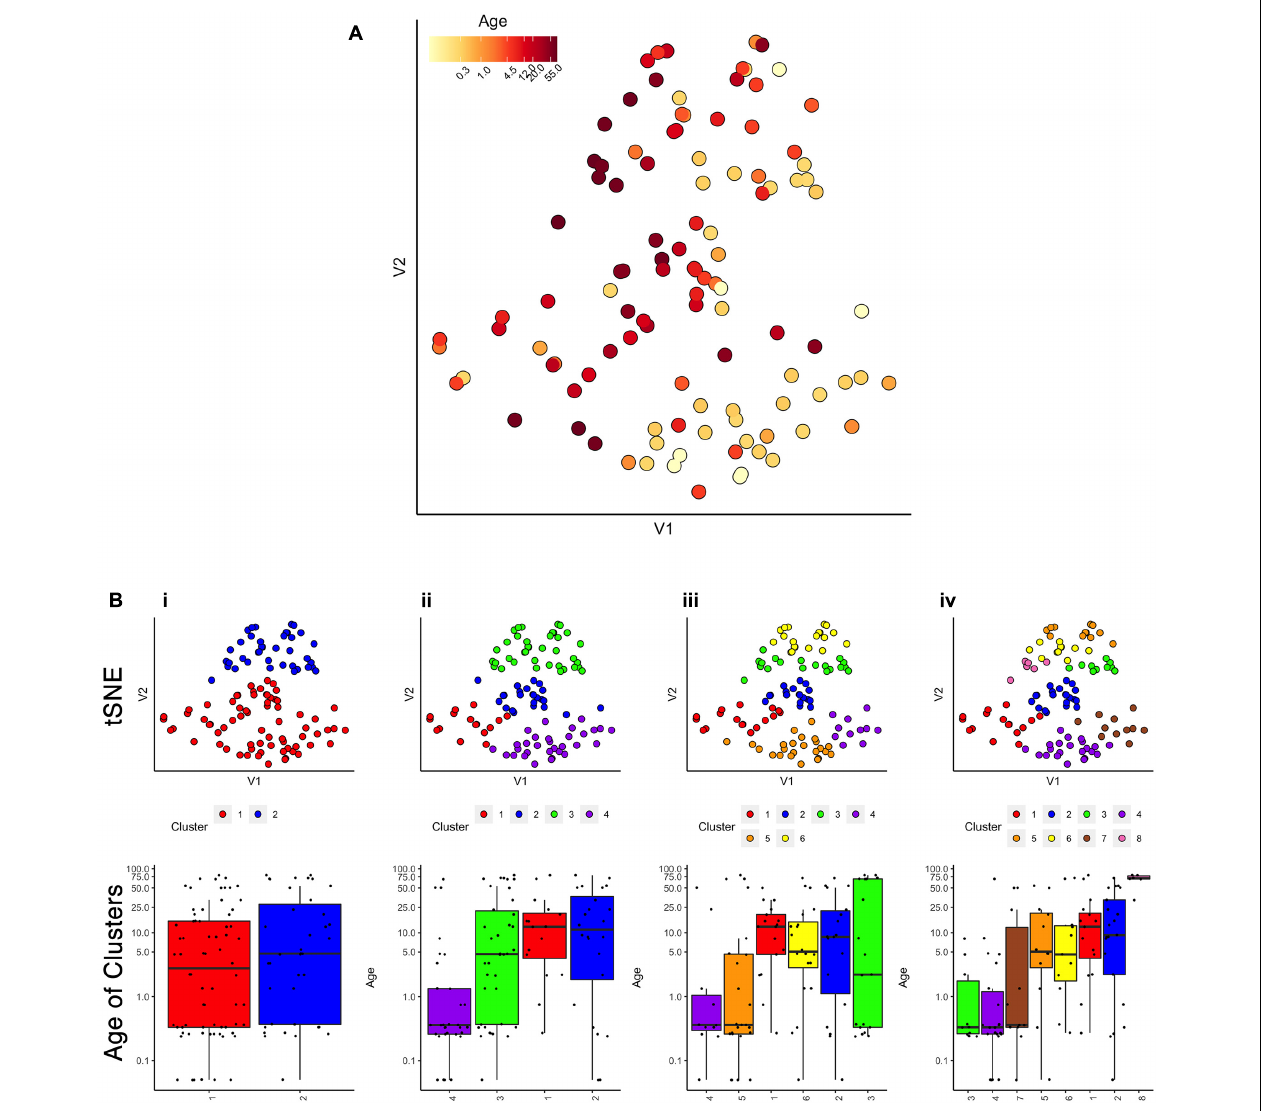
FIGURE 2 | Age-related organization of cases and initial clustering results. (A) A 2D tSNE scatter plot color-coded according to individual cases’ age. (B) tSNE 2D scatter plots and box plots showing the results of agnes for k = 2, 4, 6, and 8 case clusters. The tSNE plots display individual samples as points. Points are color-coded according to their designated cluster determined by agnes . Boxplots denote the median and interquartile range of ages in each cluster, and points denote